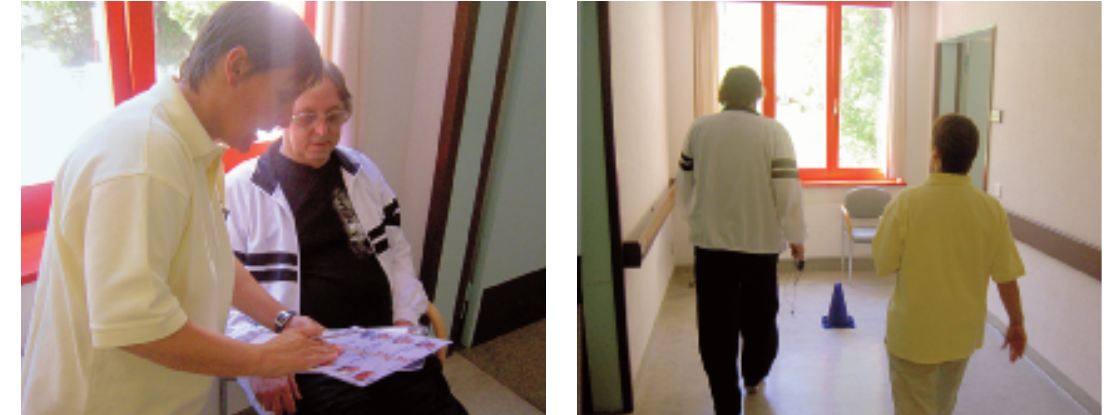
Figure 2 The 6-minute walk test requires good explanation to the patient and well stan- dardised encourage- ments.